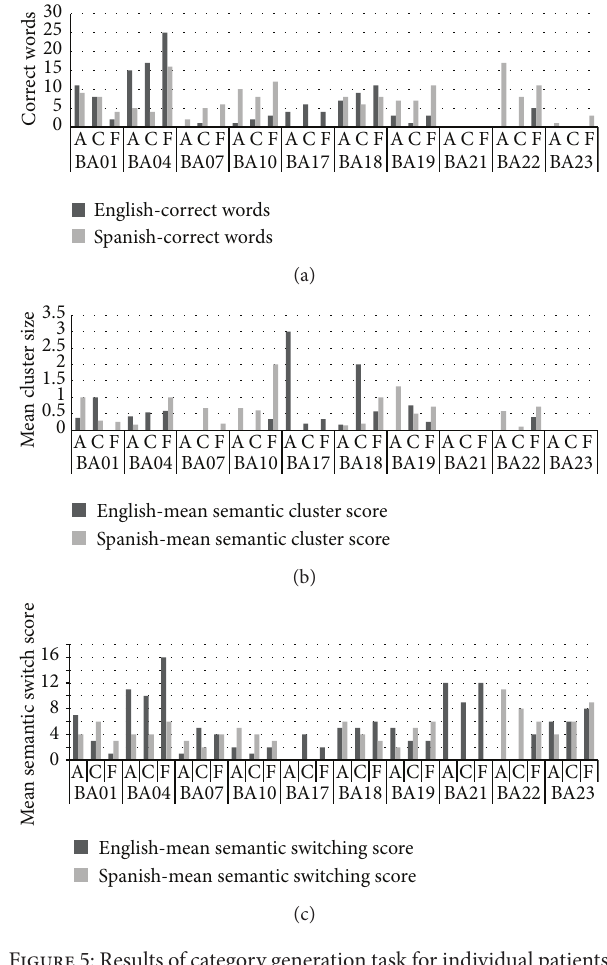
Figure 5: Results of category generation task for individual patients across three categories Animals (A), Food (F), and Clothing (C) in English and Spanish. (a) Correct Word Scores for the Category Generation Task in English and Spanish across each participant in the categories, (b) Mean Semantic Cluster Scores, and (c) Mean Semantic Switching Scores. Comparing each participant in their correct responses provided in English and Spanish exemplifies their dominant languages and individual